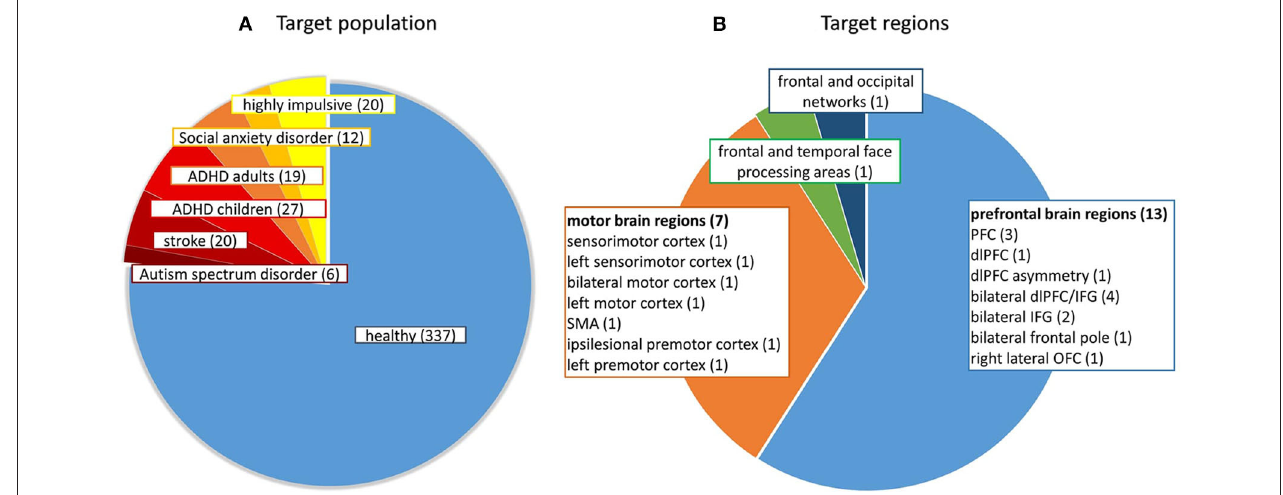
FIGURE 3 | (A) Number of participants from different target populations and (B) Number of studies targeting a certain brain region. ADHD, attention-deficit/hyperactivity disorder; dlPFC, dorsolateral prefrontal cortex; IFG, inferior frontal gyrus; OFC, orbitofrontal cortex; PFC, prefrontal cortex; SMA, supplementary motor